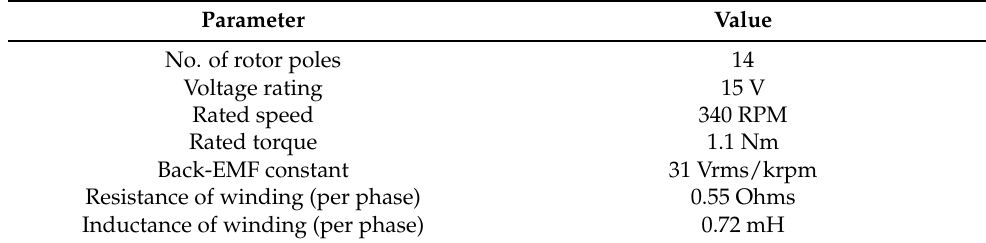
Table A3. Parameters of the BLDC ceiling fan